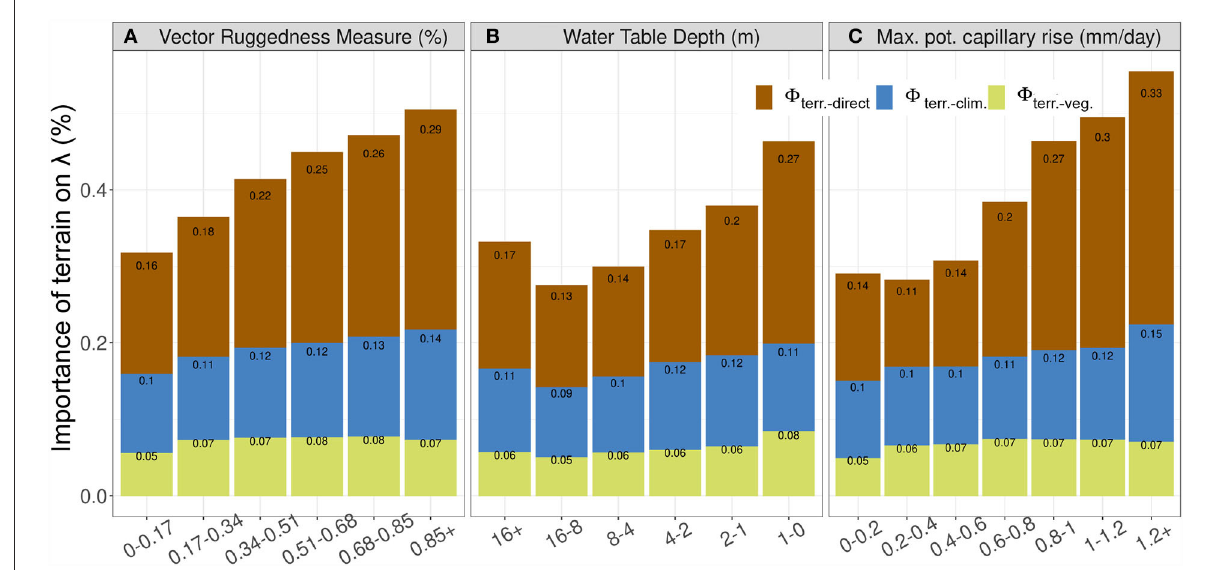
FIGURE3 Normalized importance of terrain (same as Figure 2) with change in Vector Ruggedness Measure (VRM) (A) , Water Table Depth (WTD) (B) , and maximum potential upwards capillary flux 1 m above water table depth ( I cap ) (C) . Y-axis shows the total terrain effects ( 8 terrain − total ) even though bars are colored and annotated to show its components as direct effects ( 8 terrain − direct ) and interaction effects with climate ( 8 terrain − clim ) and vegetation ( 8 terrain − veg ), using Equation